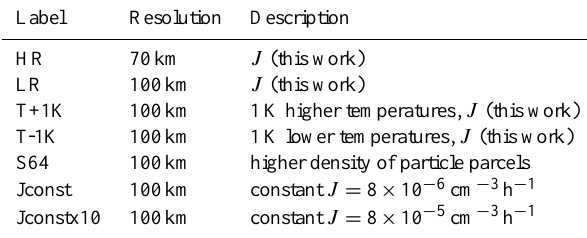
Table 1. Sensitivity simulations performed with CLaMS and cor- responding labels. Different horizontal resolutions and assumptions for the NAT nucleation rate J are